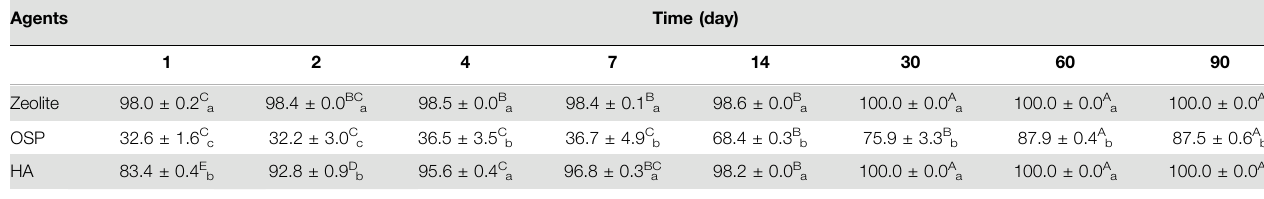
TABLE 2 | The removal ef fi ciency (%) of 1000 μ g/L of MG in freshwater treated with three agents (200 mg/L) at observation point during 90 days. Agents